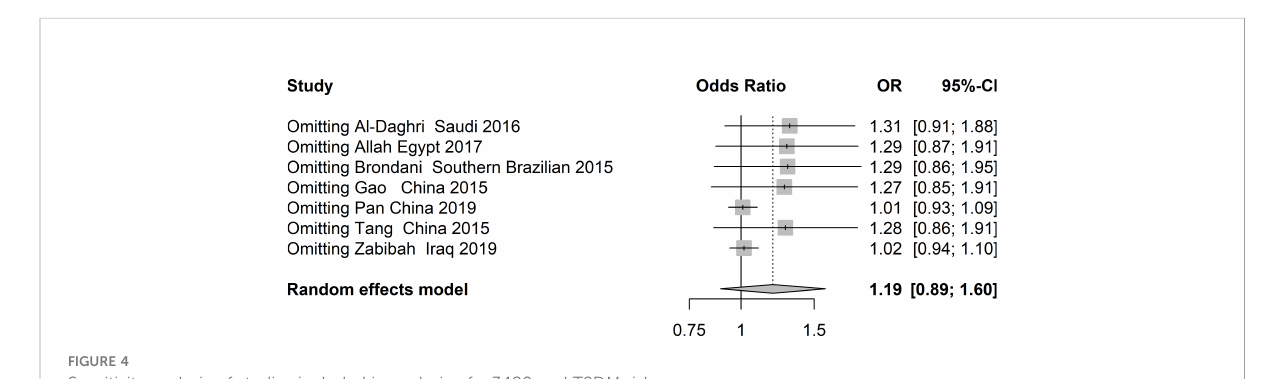
FIGURE 4 Sensitivity analysis of studies included in analysis of rs3480 and T2DM